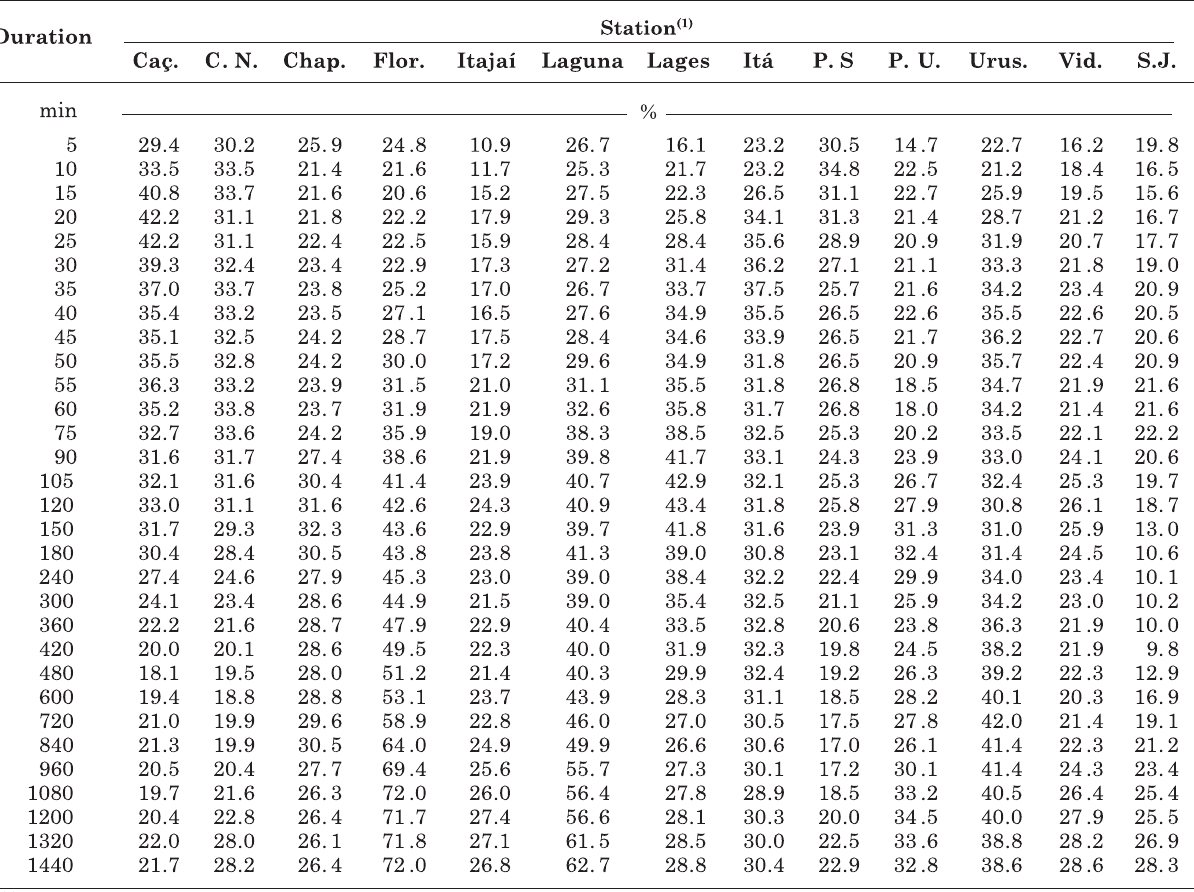
Table 3. Coefficient of variation values of the annual maximum precipitation of the rain gauge stations of Santa